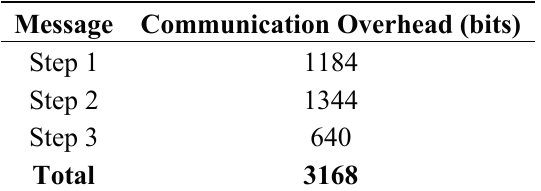
Table 4. Communication overhead of each